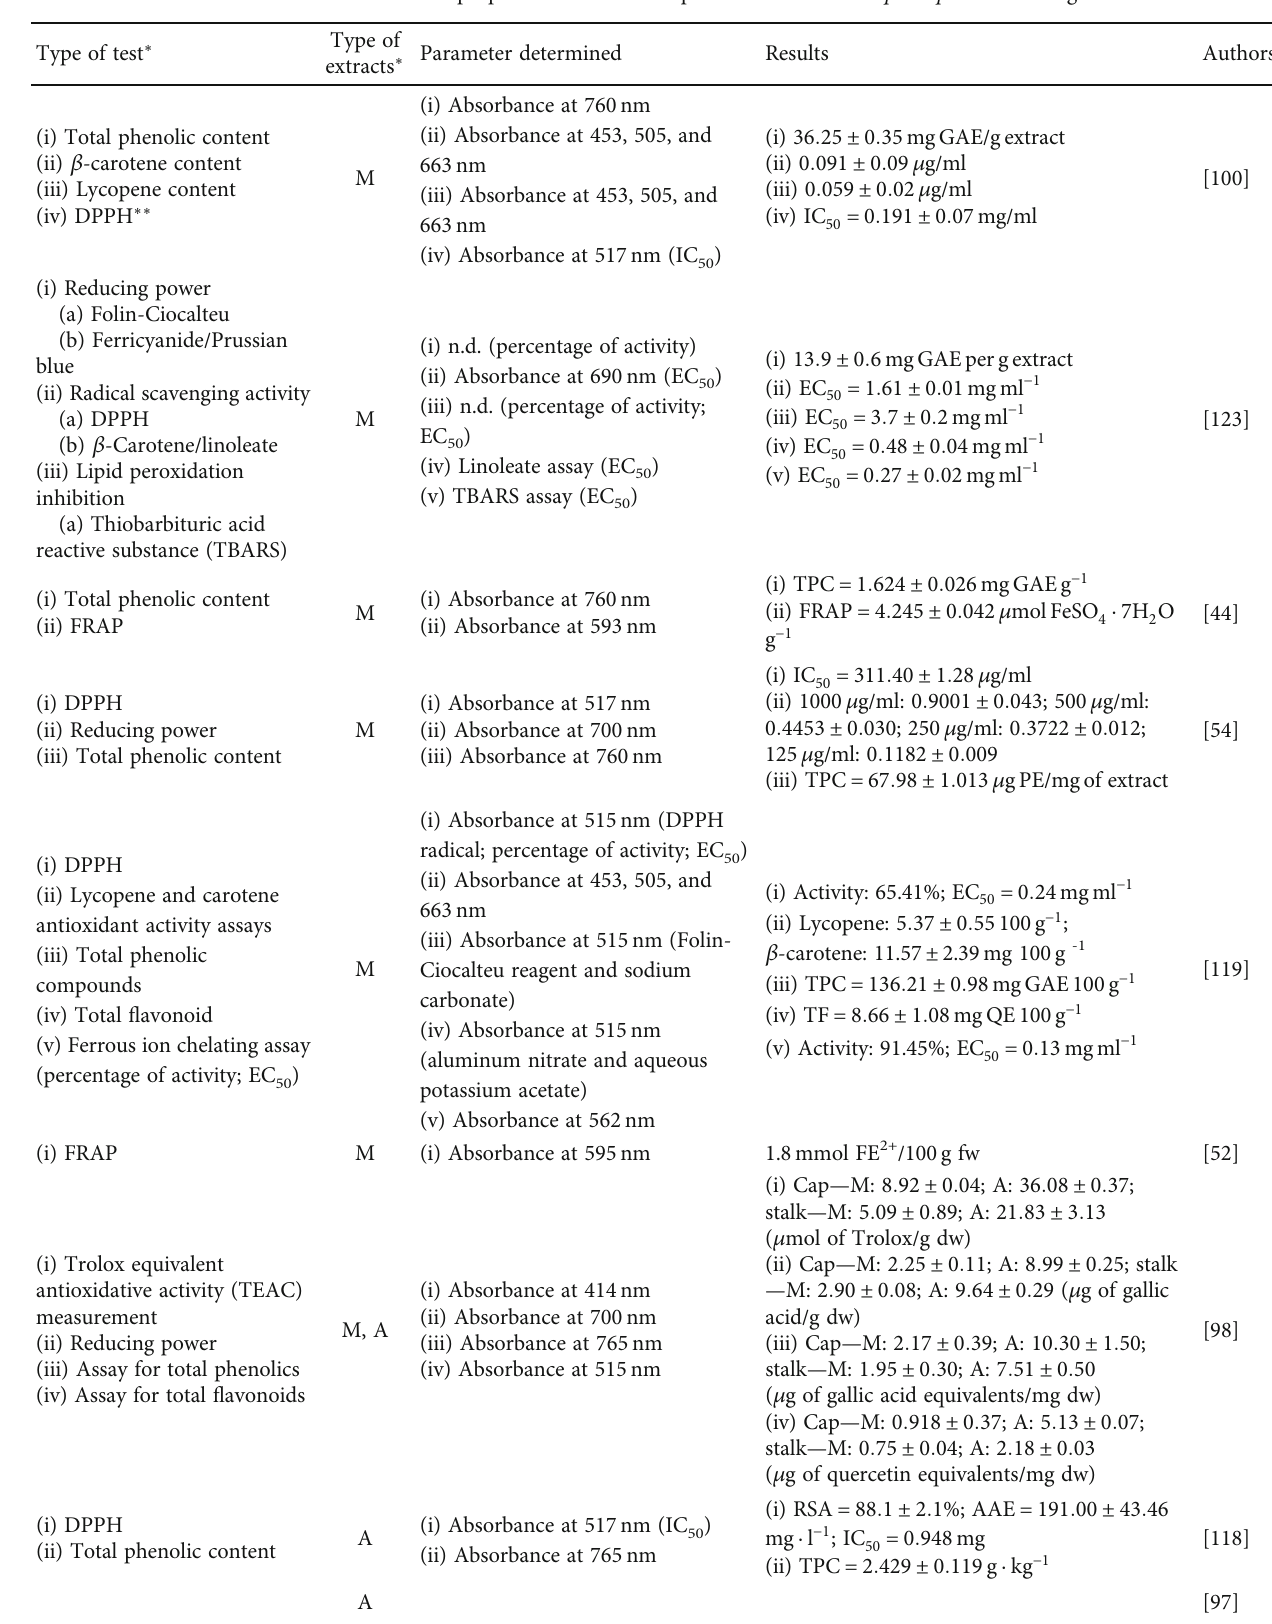
Table 3: Studies of antioxidant properties of substances present in the Macrolepiota procera fruiting